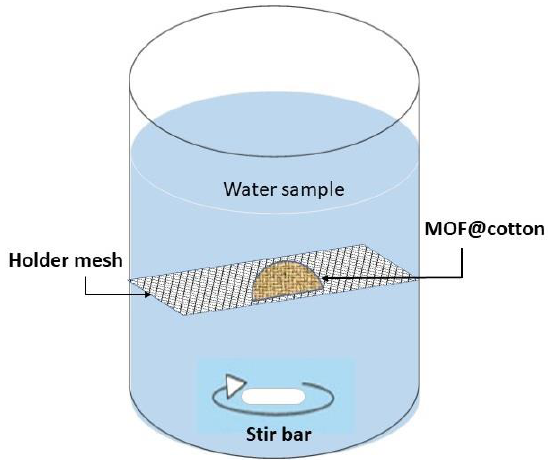
Figure 1. Experimental setup for passive diffusion sorption of contaminants on a static sorbent.